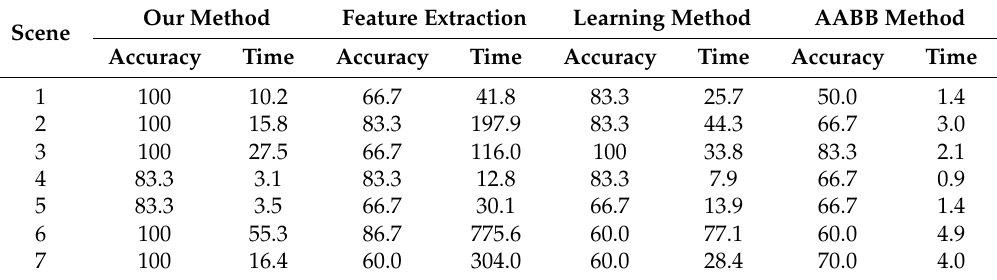
Table 3. Accuracy (%) and time (s) on the IIIT RGBD